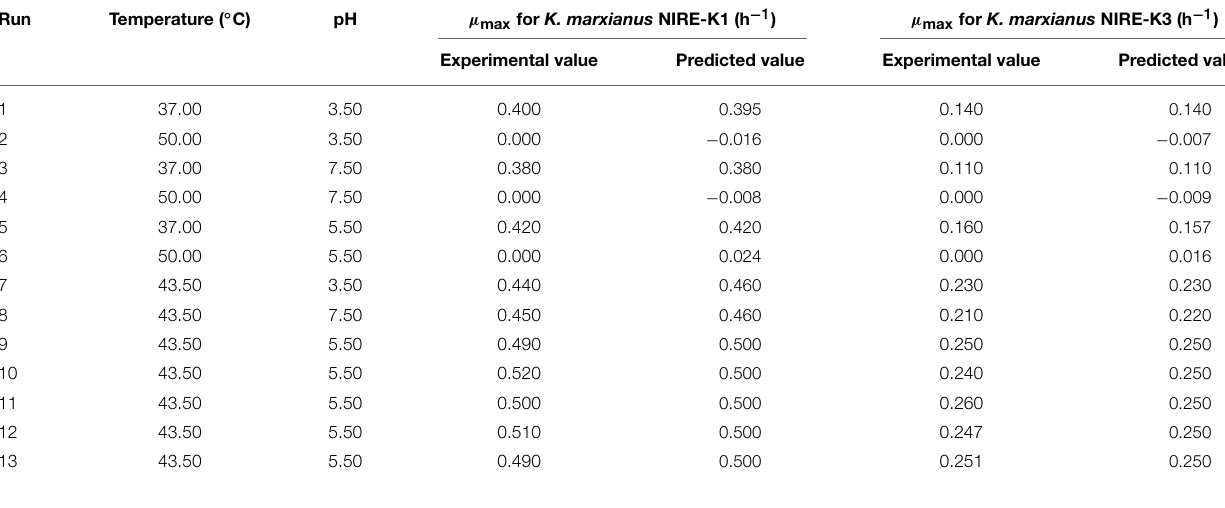
TABLE 3 | Experimental data and results of FCCD for the growth of K. marxianus NIRE-K1 and NIRE-K3. Run